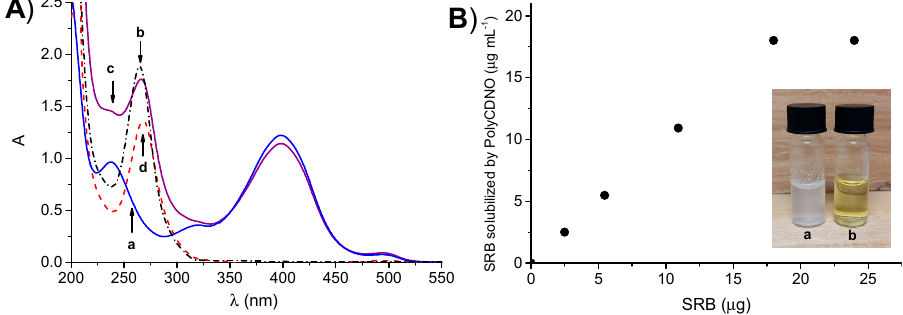
Figure 1. ( A ) Absorption spectrum of an aqueous solution of PolyCDNO (1 mg mL − 1 ) (a), a methanol solution of SRB (18 μ g mL − 1 ) (b) and an aqueous solution of PolyCDNO in the presence of SRB at 18 μ g mL − 1 (c) and the difference spectra c–a (d). ( B ) The amount of SRB solubilized by an aqueous solution of PolyCDNO (1 mg mL − 1 ) as a function of the initial amount of SRB. The images in the inset show samples of SRB (18 μ g mL − 1 ) in the absence ( a ) and in the presence ( b ) of PolyCDNO (1 mg mL − 1 ) in aqueous medium.